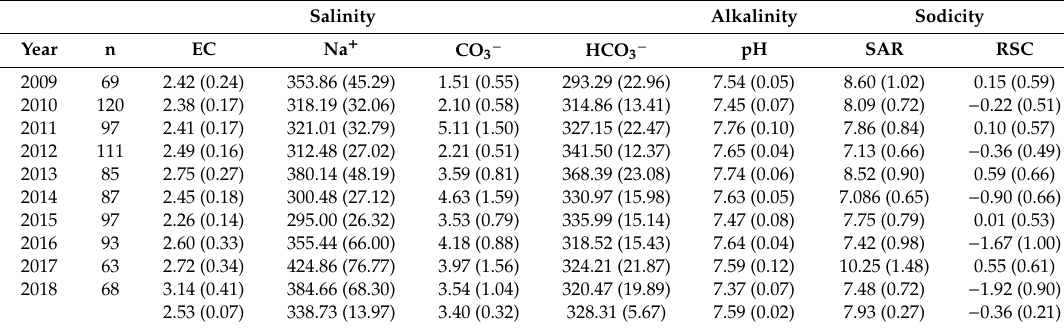
Figure 3. Changes in the mean concentration values are shown for chloride and sulphate ( A ) and for potassium, magnesium and sulphate ions ( B ). In the lower side, ion concentrations in water are plotted for boron ( C ) and nitrate ( D ). The continuous black lines represent regression lines, with a positive slope for boron and a negative slope for nitrate. The red dashed line represents the upper threshold limit of boron concentrations for all sensitive and most moderately sensitive crops. The red dashed line for nitrate represent the maximum established limits for nitrate according to the European Union directives related to good groundwater status. Table 6. Average annual and 10-year values (± standard error) of groundwater salinity, alkalinity and sodicity indices.